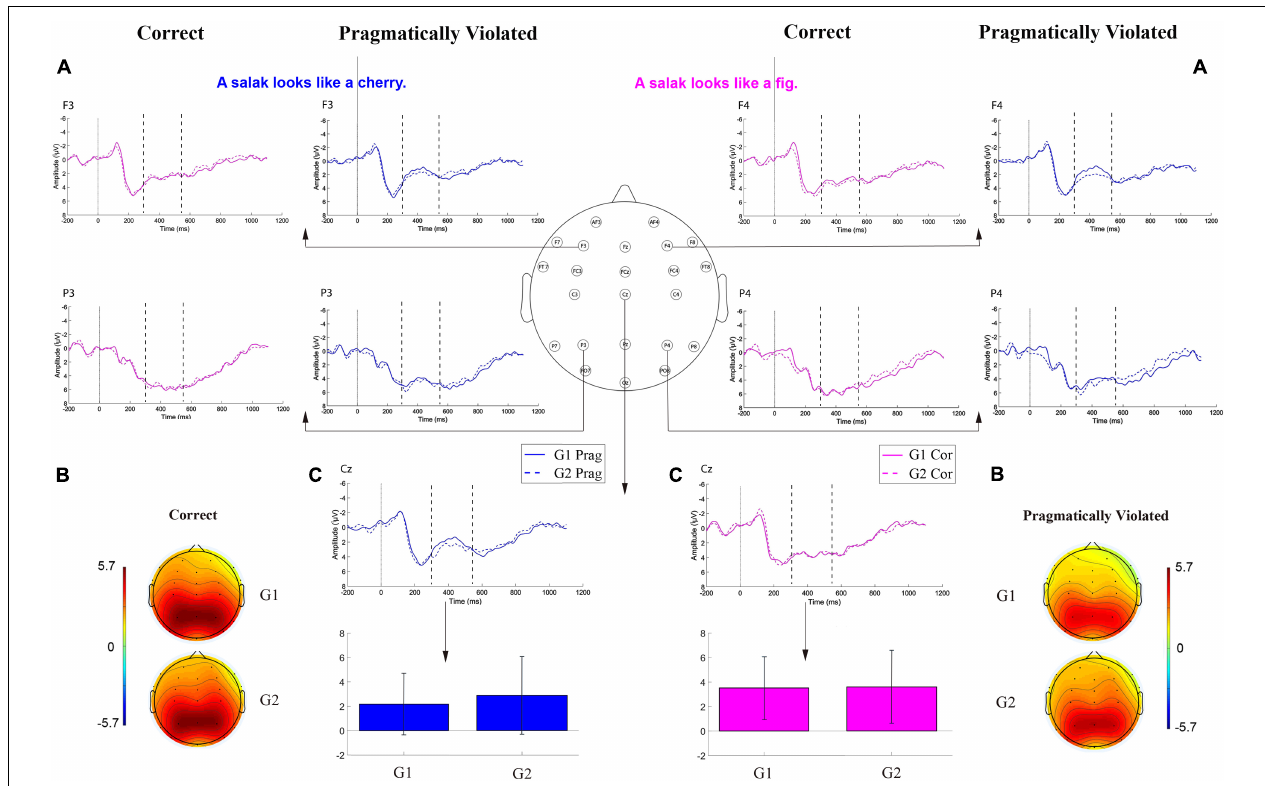
FIGURE 4 | (A) Grand-average ( N = 20 per group) ERPs time-locked to the onset of the critical word for the correct (Cor) and pragmatically violated (Prag) conditions in G1 and G2 at F3/4, P3/4, and Cz as sample locations. (B) The topographic maps show the distribution of the N400 for both groups regarding both conditions. (C) The bar plots show no significant difference between the two groups with regard to correct (pink) and pragmatically violated sentences (blue).